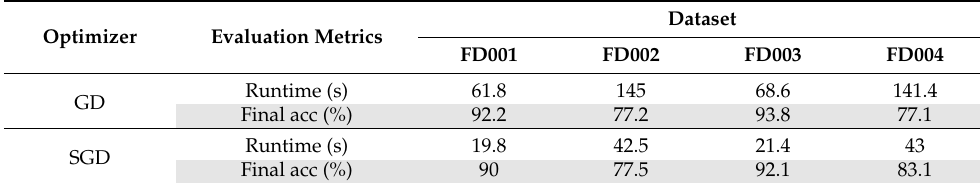
Table 3. Performance analysis of the asynchronous